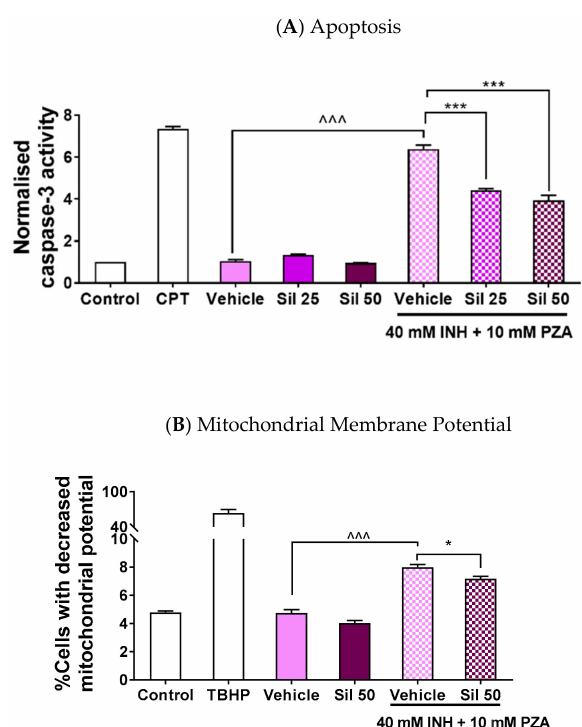
Figure 4. Silibinin reduced apoptosis when co-administered with a combination of INH and PZA by maintaining mitochondrial membrane potential. Various concentrations of silibinin were co-administered with I / P 40 / 10 over 18 h. ( A ) The administration of I / P 40 / 10 significantly increased caspase-3 activity (one-way ANOVA, p < 0.0001). The co-administration of silibinin with I / P 40 / 10 reduced the activity of caspase-3 when silibinin was administered at 25 µ M (one-way ANOVA, p < 0.0001) and 50 µ M (one-way ANOVA, p < 0.0001), suggesting that there was a reduction in apoptotic activity. The positive control was treated with camptothecin (CPT) 5 µ M for 24 h. ( B ) The administration of I / P 40 / 10 negatively a ff ected LO2 cells’ membrane potential (one-way ANOVA, p < 0.0001). Silibinin of 50 µ M reduced the percentage of cells whose membrane potential was negatively a ff ected by I / P 40 / 10 (one-way ANOVA, p = 0.0234). Positive control was treated with the oxidising agent TBHP 200 µ M for 1 h. Data represent mean ± S.E.M. of three replicates. * p < 0.05, *** p < 0.001 vs.